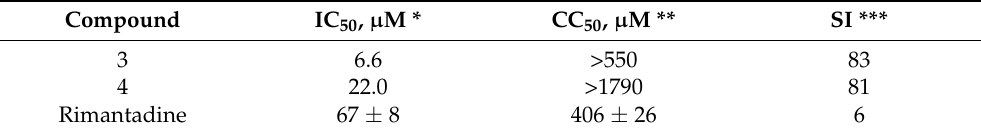
Table 2. Activity of 3-aminoisoxazolines 3 , 4 against WT A/Puerto Rico/8/34 (H1N1) virus.